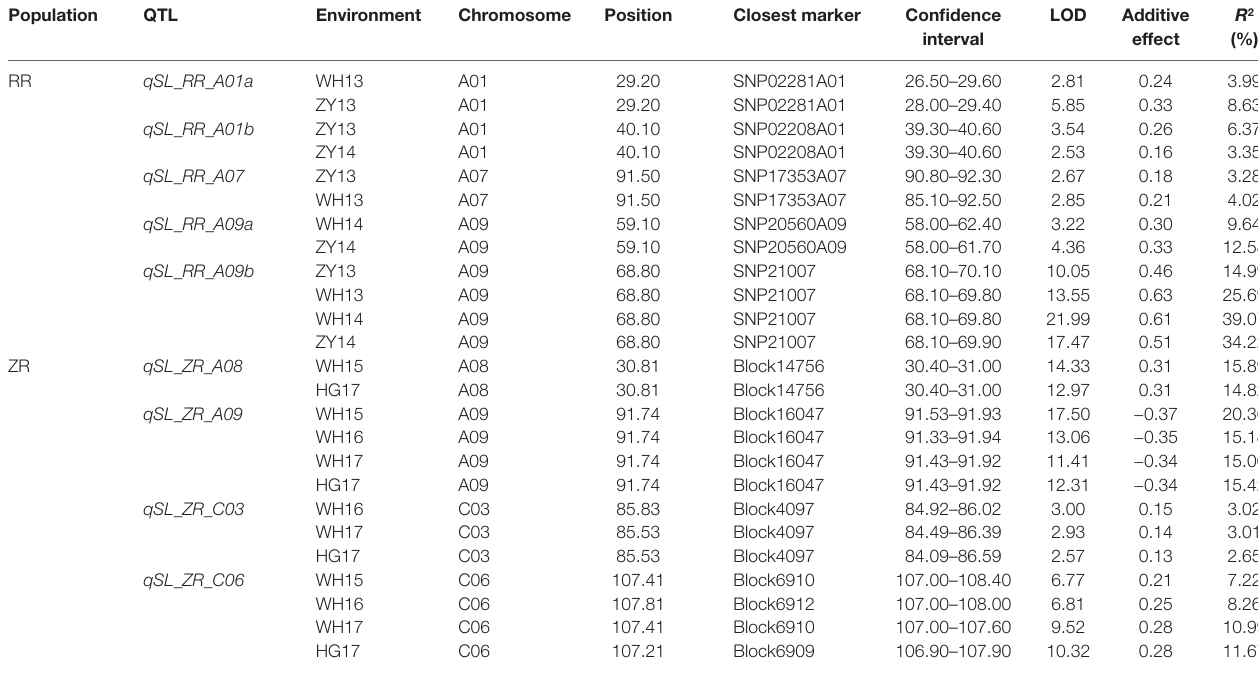
TaBLe 4 | Repeatedly detected quantitative trait loci (QTL) for silique length (SL) in different environments in RR and ZR populations.